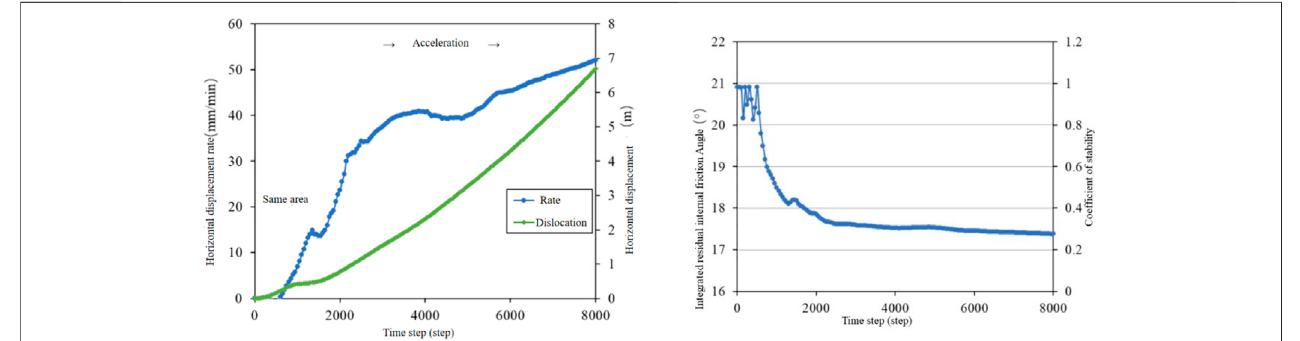
FIGURE 15 | Horizontal displacement rate and horizontal cumulative displacement curve of monitoring point